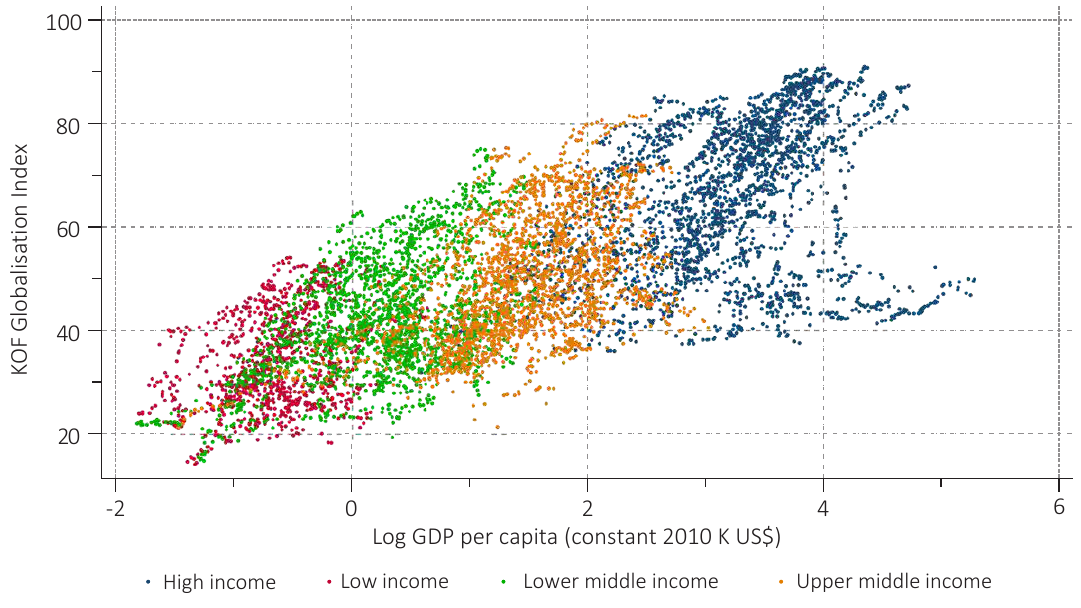
Figure 3. Scatter diagram of GDP per capita and globalization